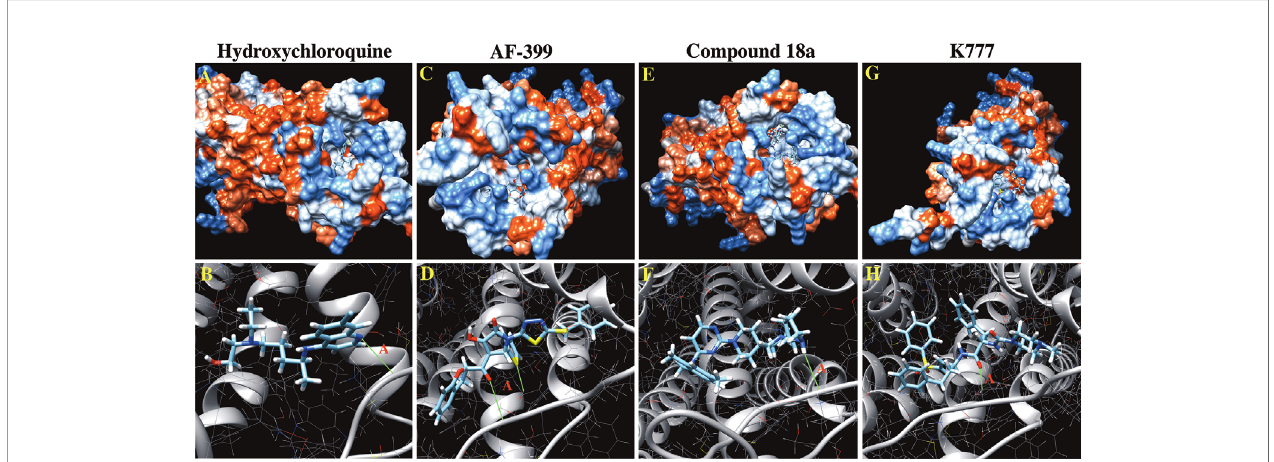
FIGURE 2 | In Silico docking images for hydroxychloroquine and controls against CCR4. (A) Hydrophobicity plot demonstrating hydroxychloroquine interacting with the CCR4 active site. (B) Hydroxychloroquine forms a hydrogen bond with Thr-189 (A) in the CCR4 active site, as depicted in green. (C) Hydrophobicity plots demonstrating AF-399 interacting with the CCR4 active site. (D) AF-399 forms a hydrogen bond with Thr-189 (A) in the CCR4 active site. (E) Hydrophobicity plots demonstrating compound 18a interacting with the CCR4 active site. (F) Compound 18a forms a hydrogen bond with Thr-189 (A) in the CCR4 active site. (G) Hydrophobicity plots demonstrating K777 interacting with the CCR4 active site. (H) K777 forms a hydrogen bond with Thr-189 (A) in the CCR4 active